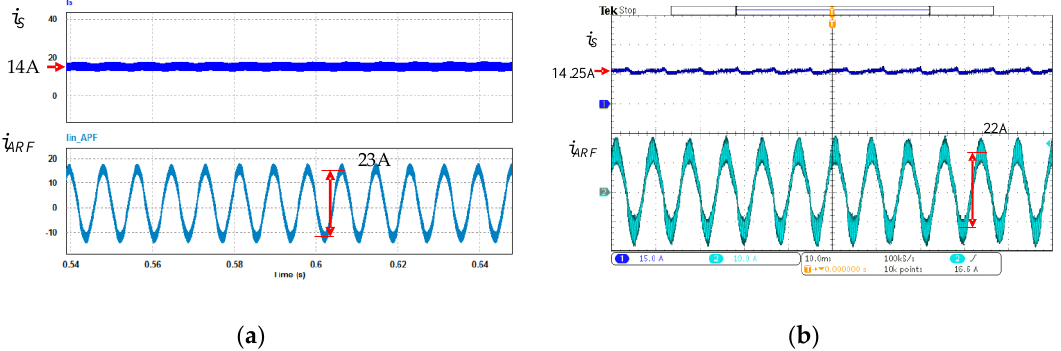
Figure 13. Steady-state of the output voltage and inductor current of the ARF: ( a ) Simulation result and ( b ) experimental result.